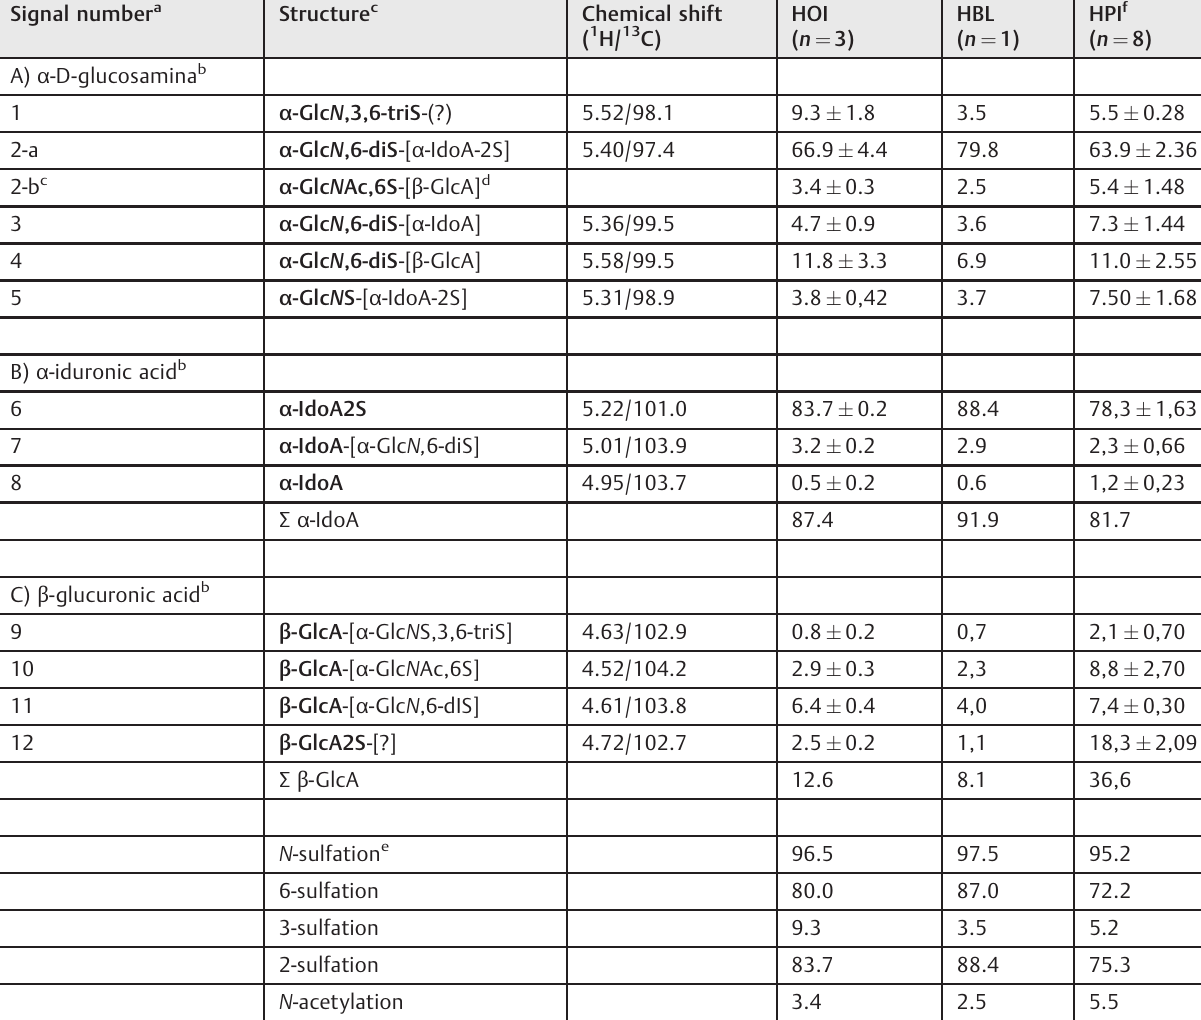
Table 2 Proportions of the constituent units of HOI, HBL and HPI based on 2D 1 H/ 13 C HSQC spectra Signal number